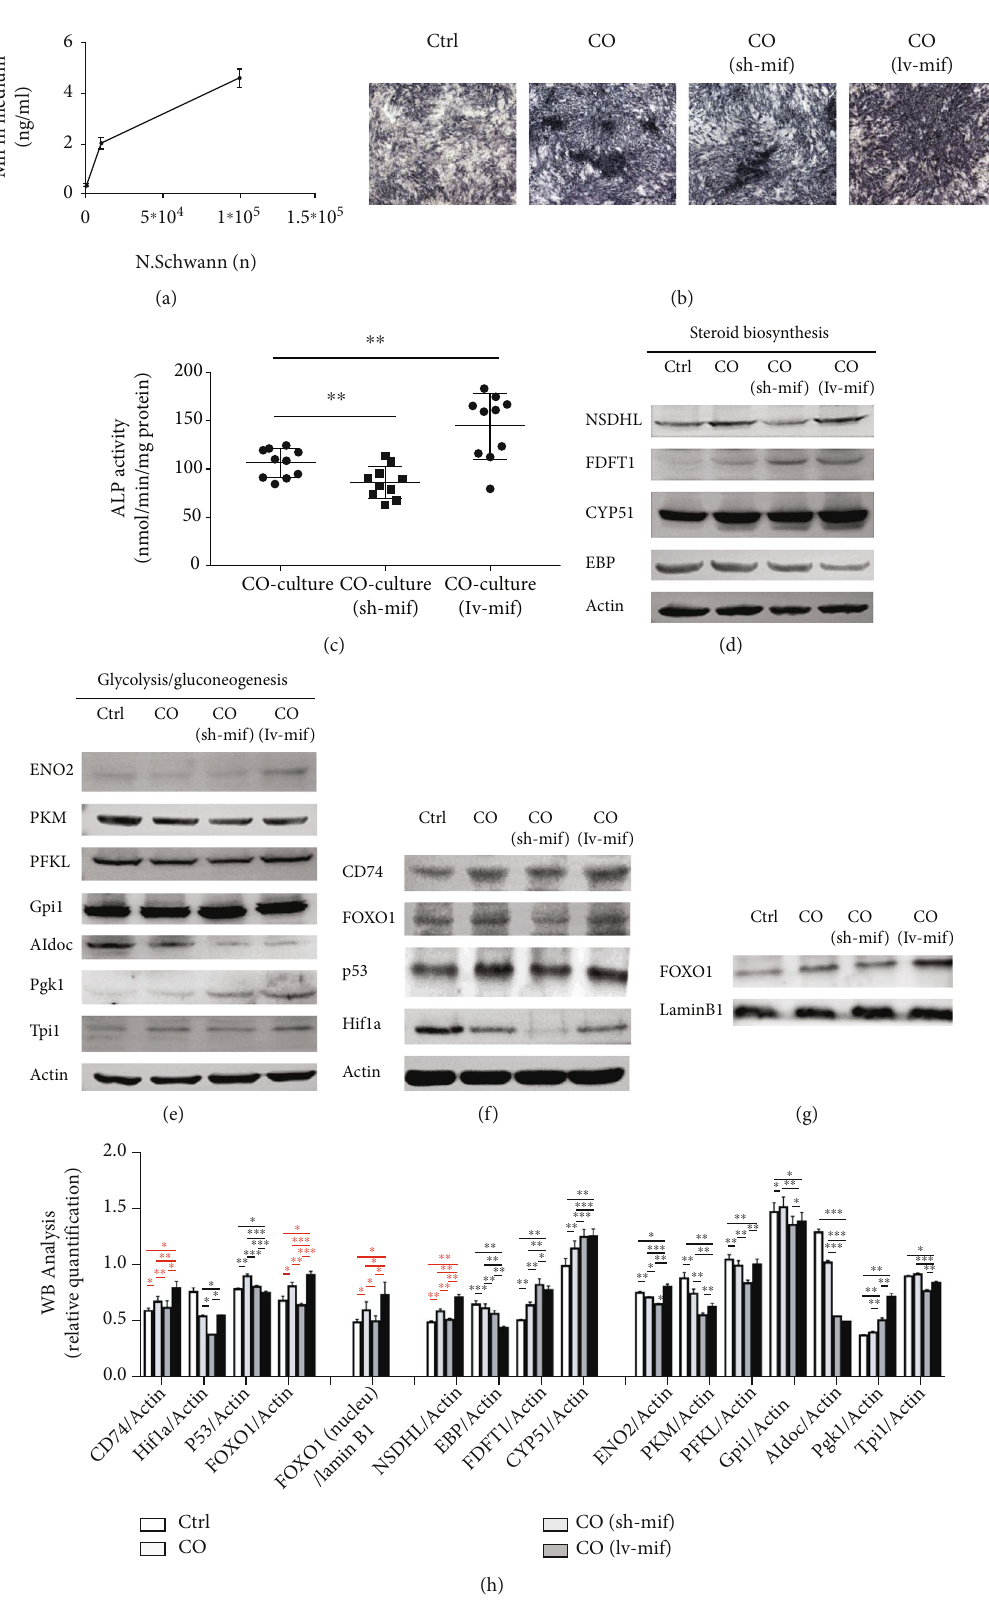
Figure 5: Schwann cells promote osteogenesis by Mif/CD74/FOXO1 signaling. (a) Mif concentration in the medium released from Schwann cells; (b) representative images showing ALP staining; (c) ALP activity was measured with an ALP assay kit, n = 6 ; (d – h) representative WB images for steroid biosynthesis (d), glycolysis/gluconeogenesis (e), and signaling pathway (f, g). WB analysis was also quanti fi ed by